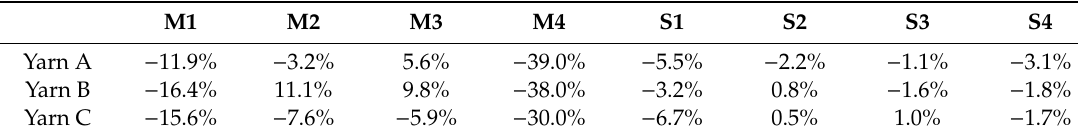
Table 1. Lightness variation of the electrodes of different lots after 30 washes.